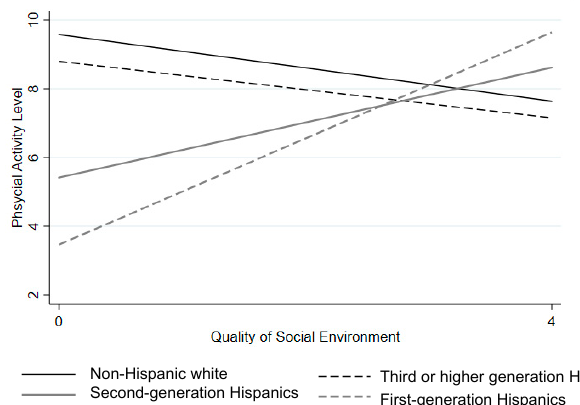
Figure 2. Predicted physical activity associated with the social environment by child immigrant generation, as shown in Table 4, Model 3, setting all other variables within the model at their average value. Note. The social environment was measured based on a four-item scale on neighborhood safety, traffic, and crime. Higher scores indicate higher quality social environment.